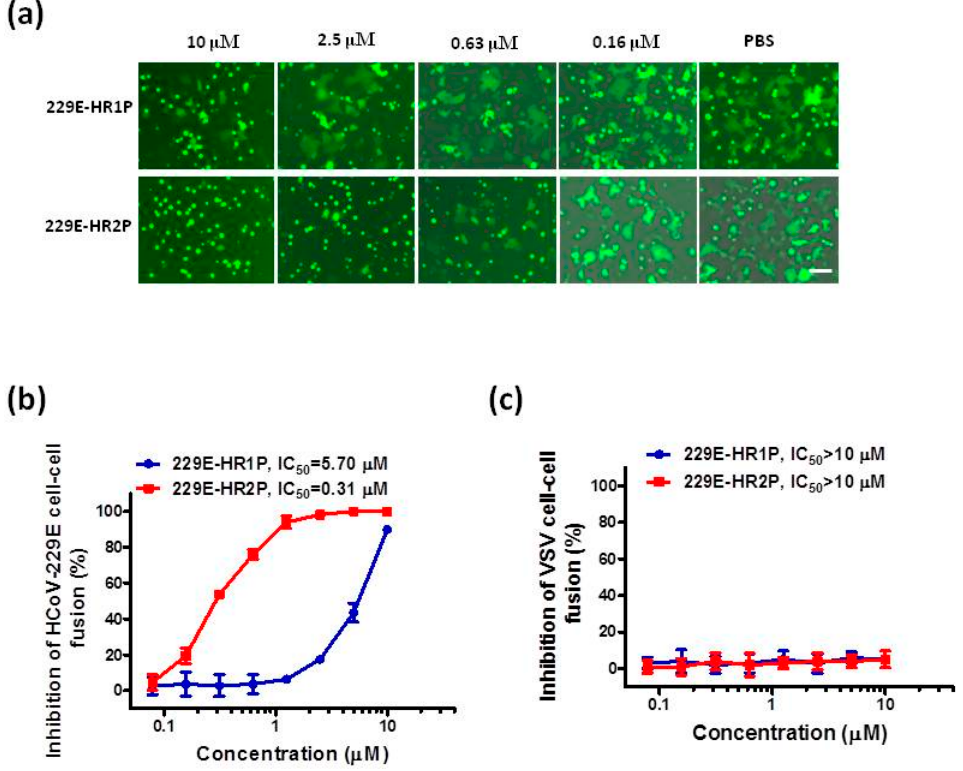
Figure 4. Inhibitory activities of 229E-HR1P and 229E-HR2P on cell-cell fusion mediated by HCoV-229E S protein or vesicular stomatitis virus (VSV) G protein. ( a ) Images of 229E S protein-mediated cell-cell fusion in the presence of 229E-HR1P (upper) and 229E-HR2P (lower) at different concentrations; ( b ) Inhibitory activities of 229E-HP1P and 229E-HR2P against HCoV-229E S-mediated cell-cell fusion; ( c ) Inhibitory activities of 229E-HP1P and 229E-HR2P on VSV G-mediated cell-cell fusion. Data are means ± SD of triplicate samples from a representative experiment. Scale bars, 800 µm.